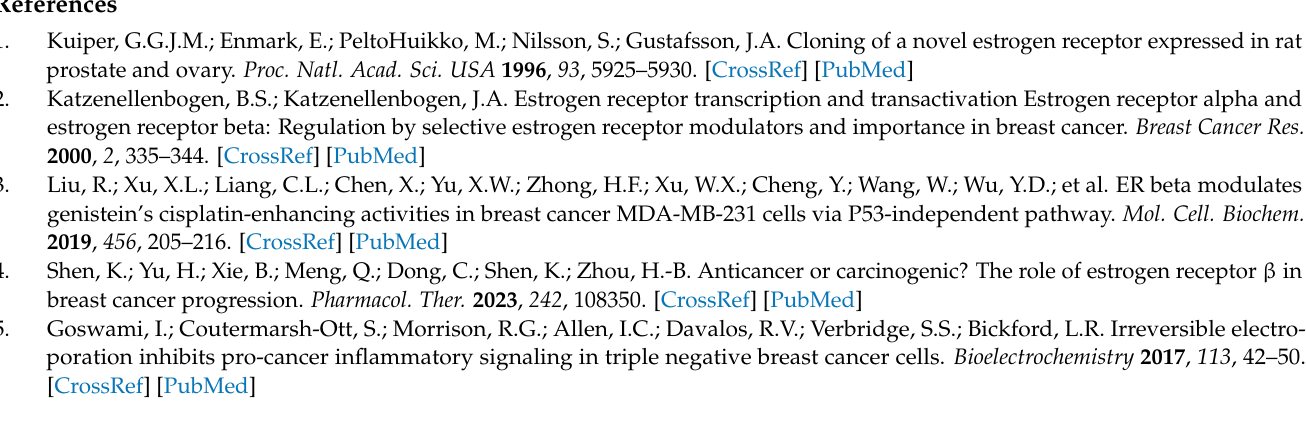
solution incubated with P2 . Figure S5: HMRS spectra of P1 . Figure S6: HMRS spectra of P2 .